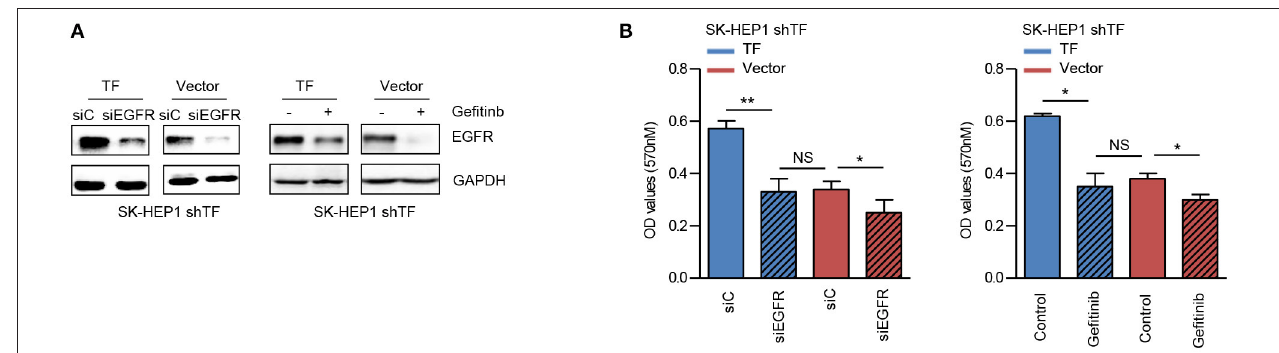
FIGURE 4 | Inhibition of EGFR suppresses TF-mediated HCC growth. SK-HEP1 shTF-Vector and SK-HEP1 shTF-TF cells were transfected with siControl or siEGFR or treated with/without gefinib at the concentration of 10 µ M for 24h. (A) Western blot and (B) MTT assay analysis of the protein expressions and cell growth. Error bars, mean ± SD. * p < 0.05 and ** p < 0.01 (two-tailed Student’s t -test B ).